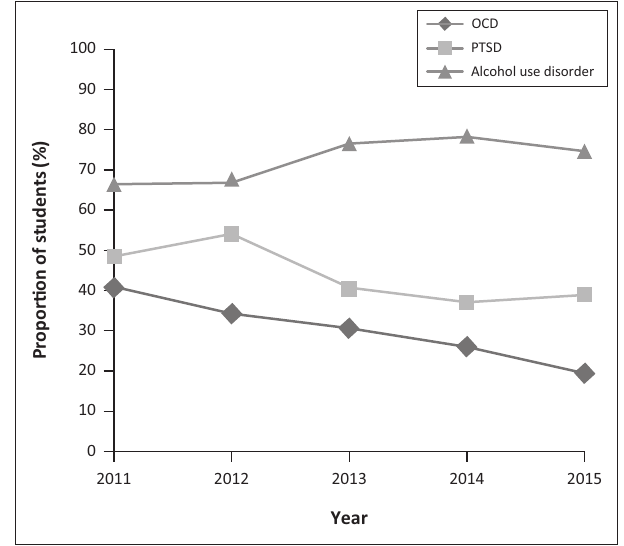
FIGURE 2: Proportion of students exposed to post-traumatic stress disorder (PTSD), obsessive-compulsive disorder (OCD) and alcohol use disorder by year ( % TABLE 2: Differences between year groups with respect to proportion of students exposed to various psychiatric conditions. Mental disorders Proportion of students exposed % (95 % confidence interval) p -value